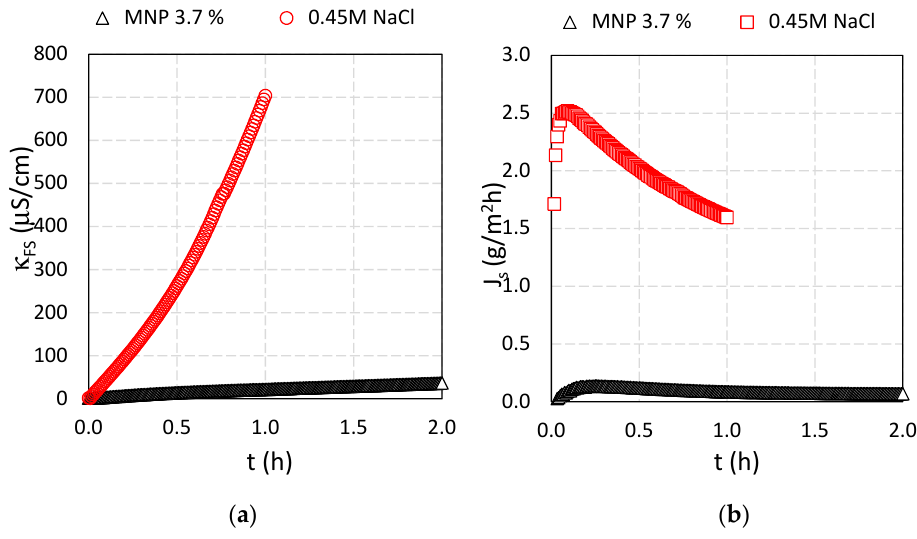
Figure 10. ( a ) Conductivity of FS and ( b ) revere salt fluxes during the time for 0.45 M NaCl and Fe 3 O 4 @CA as DS and DI water as FS, respectively.